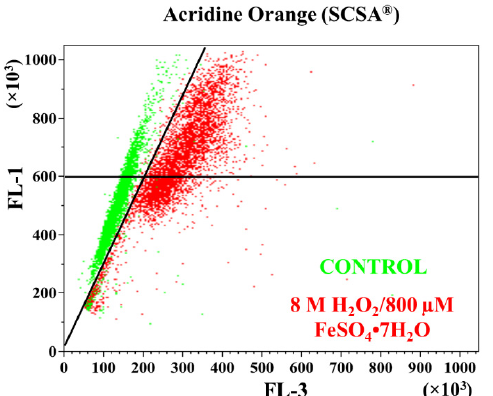
Figure 6. Assessment of sperm chromatin status. Cytogram obtained after carrying out the SCSA ® protocol. Green dots correspond to a sample that has not been treated with oxidant solution, and red dots correspond to a sample submitted to high exogenous oxidative stress. Dots plotted to the right of the diagonal line have increased DNA fragmentation index (DFI), and dots plotted above to the horizontal line have increased high DNA stainability (HDS).